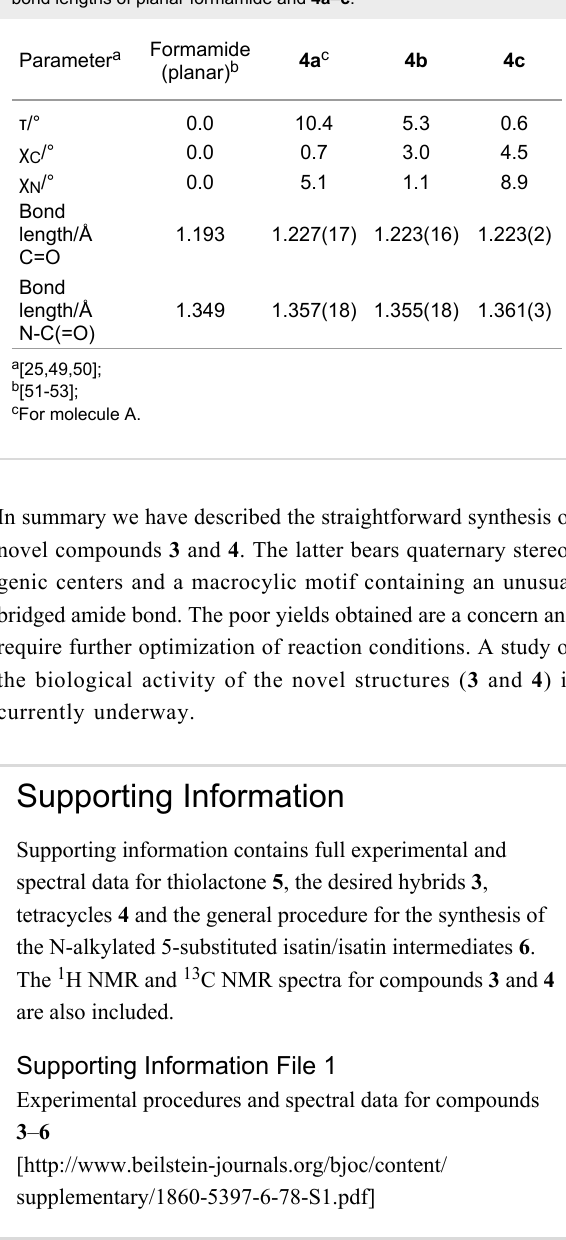
Table 3: Calculated Dunitz-Winkler distortion parameters and amide bond lengths of planar formamide and 4a – c .